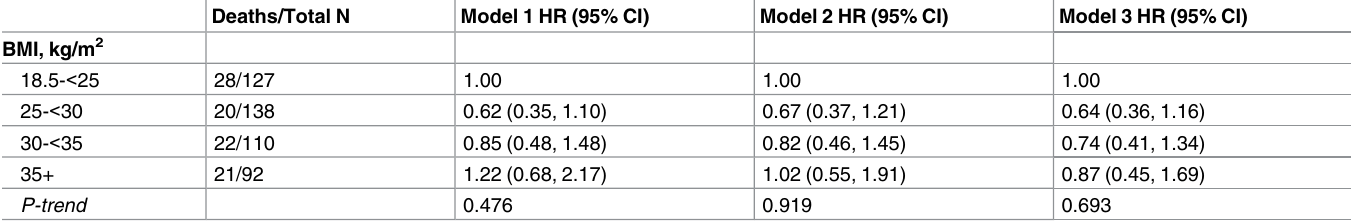
Table 2. Hazard ratios and 95% confidence intervals for body massindex (BMI) and mortality risk among endometrial cancer survivorsin the WHI (n =